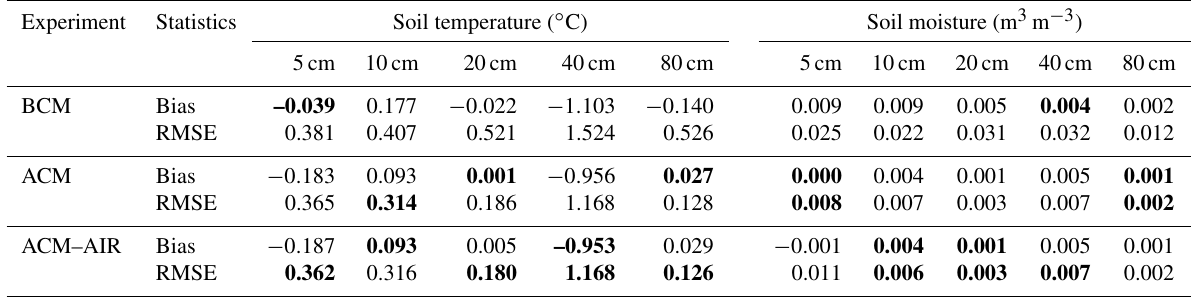
Table 3. Comparative statistical values of observed and simulated soil temperature and moisture with three models, with the bold font indicating the best statistical performance.